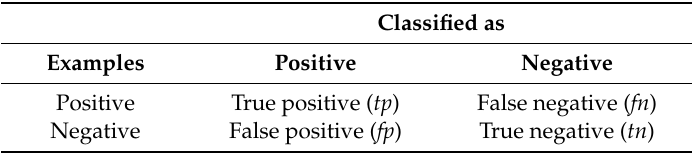
Table 7. Confusion matrix for a two-class classification